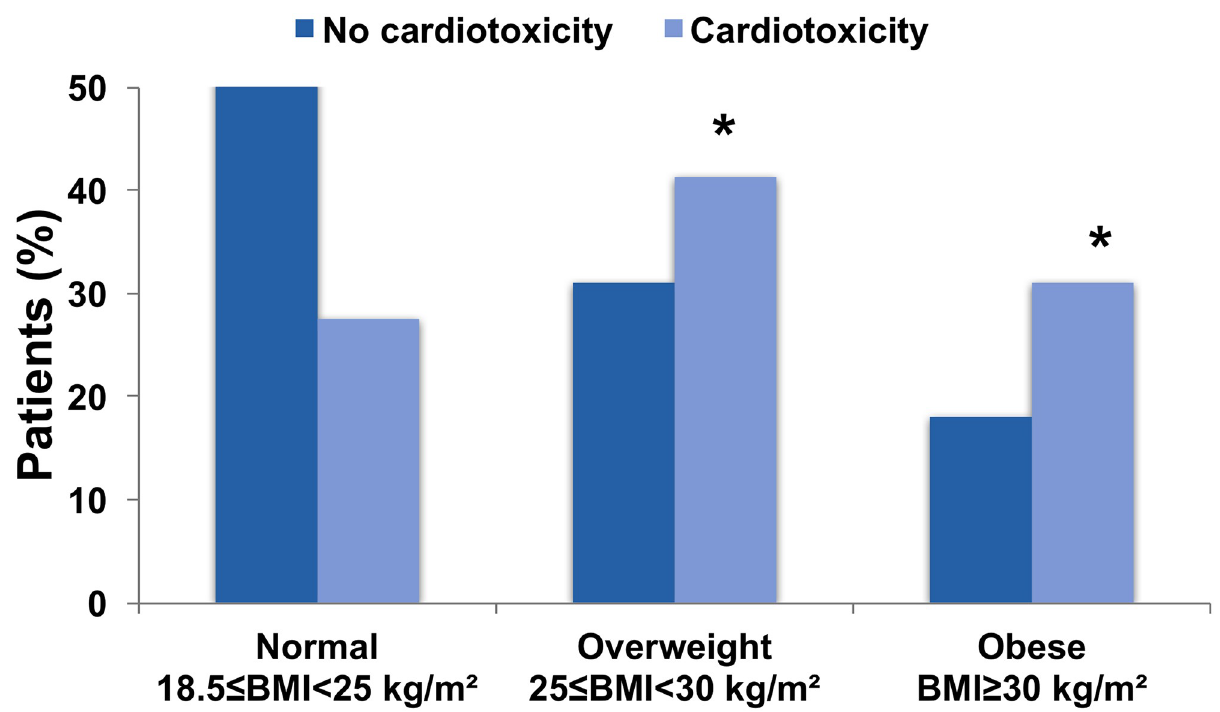
Fig 3. Association of body mass index with cardiotoxicity. � p < 0.05 versus normal weight.